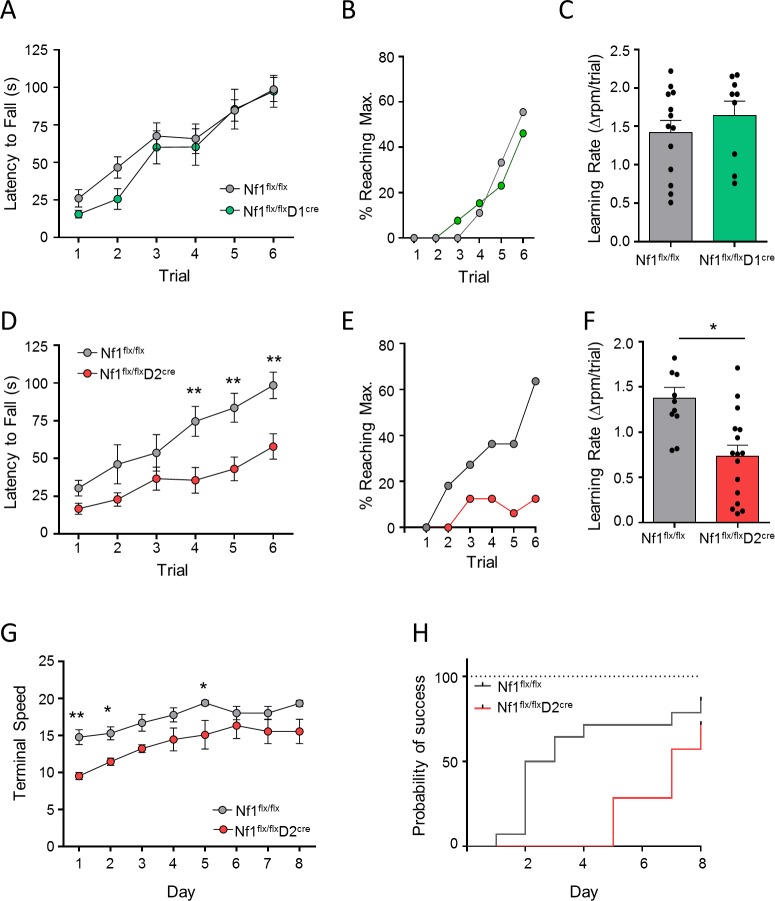
Action of NF1 in D2R-MSNs but not in D1R-MSNs is required for motor learning.(A) Performance of Nf1flx/flx and Nf1flx/flxD1cre mice on the accelerating rotarod. n = 9–13 mice/group. Two-way RM ANOVA. (B) Percentage of mice able to reach maximal speed and (C) learning rate on the accelerating rotarod for Nf1flx/flx and Nf1flx/flxD1cre mice. (D) Performance of Nf1flx/flx and Nf1flx/flxD2cre mice on the accelerating rotarod. n = 11–16 mice/group. Two-way RM ANOVA. (E) Percentage of mice able to reach maximal speed and (F) learning rate on the accelerating rotarod for Nf1flx/flx and Nf1flx/flxD2cre mice. (G) Time course of the terminal speed (trial 4) over 10 days of consecutive training on the accelerating rotarod for Nf1flx/flx and Nf1flx/flxD2cre mice. Two-way RM ANOVA. (H) Probability of reaching maximal speed over the 10 days of training on the accelerating rotarod. *P < 0.05, **P < 0.01. Data are represented as mean ± SEM. Underlying data for this figure can be found in S1 Data. D1R, D1 dopamine receptor; D2R, D2 dopamine receptor; MSN, medium spiny neuron; NF1, neurofibromin 1; RM-ANOVA, repeated measures analysis of variance.